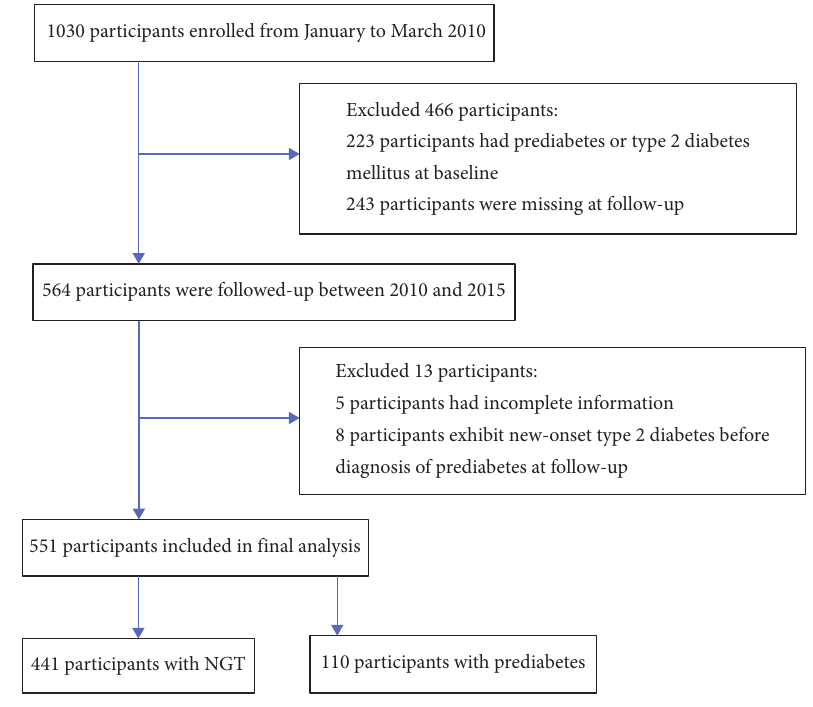
Figure 1: Schematic presentation for participant